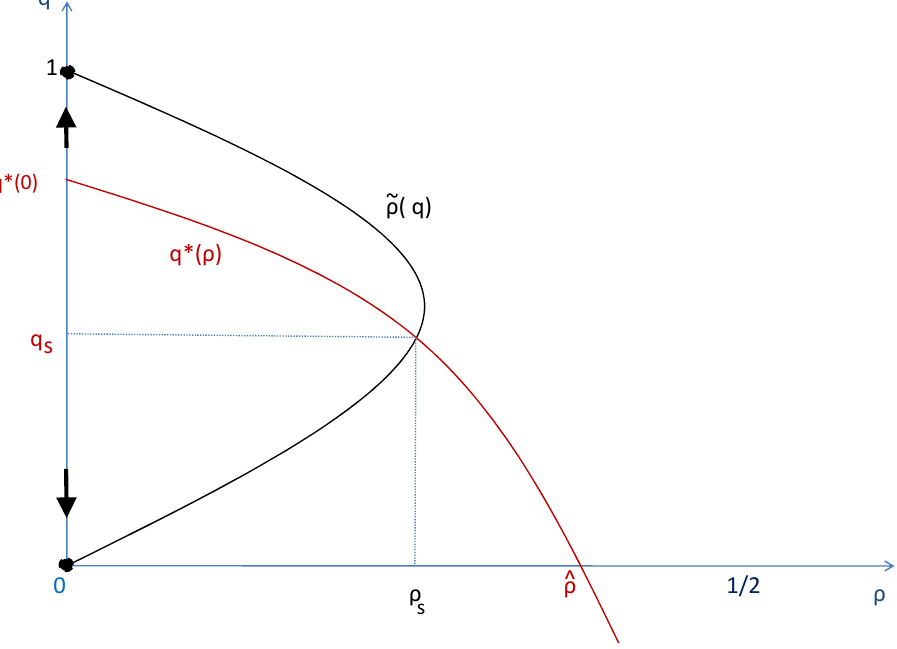
Figure 2. Graphic of ˜ ρ ( q ) and q ∗ ( ρ ) and cultural